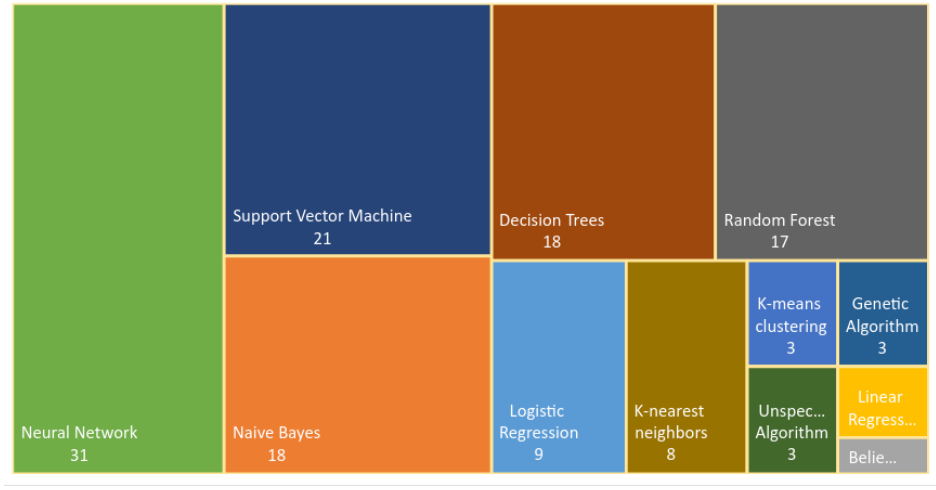
Figure 13. Distribution of the ML algorithms used. RQ-ML2: What characteristics did the ML models included present?